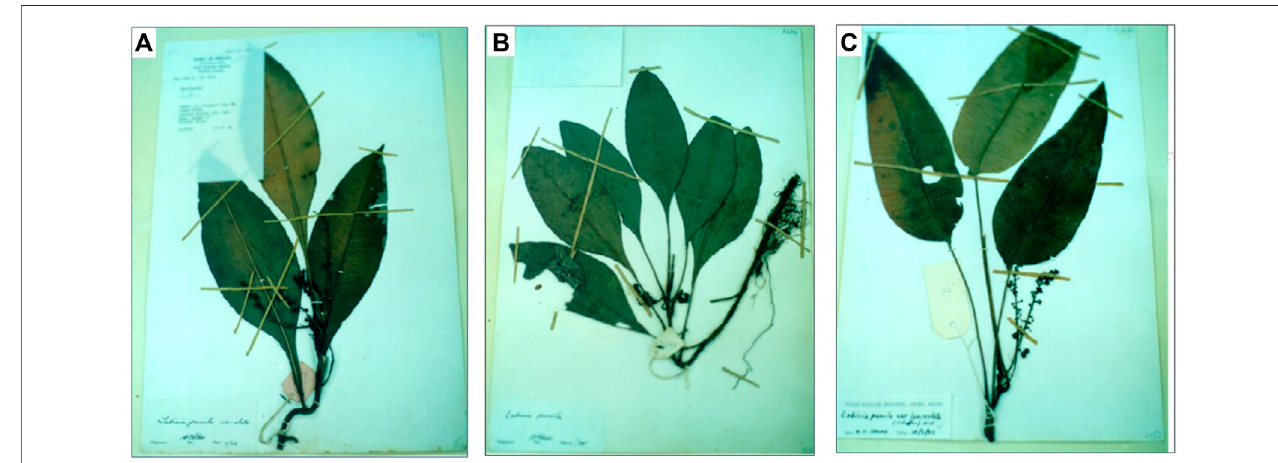
FIGURE1| Voucherspecimensof (A) Marantodespumilum var. alata , (B) Marantodespumilum var. pumila and (C) Marantodespumilum var. lanceolata (obtained from the Kepong Herbarium of Forest Research Institute Malaysia).